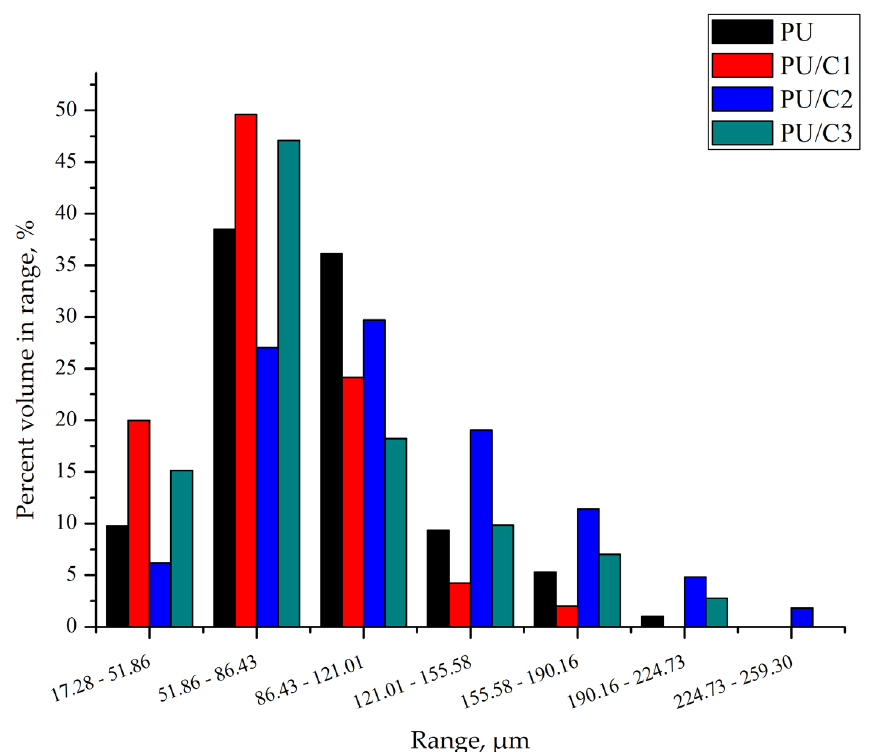
Figure 8. Distribution of pore size in PU foam and its composites with 1 php cellulose (PU/C1), 2 php cellulose (PU/C2), and 3 php cellulose (PU/C3).